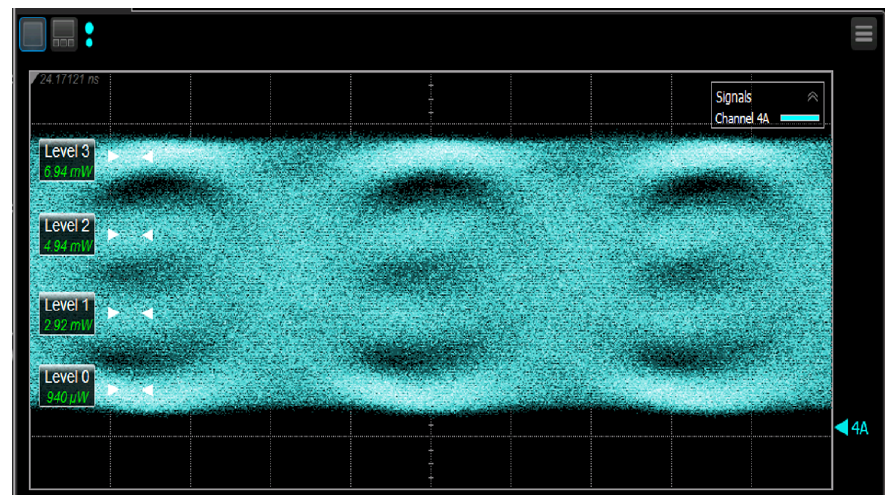
Figure 13. QSFP28 Optical PAM4 eye pattern.